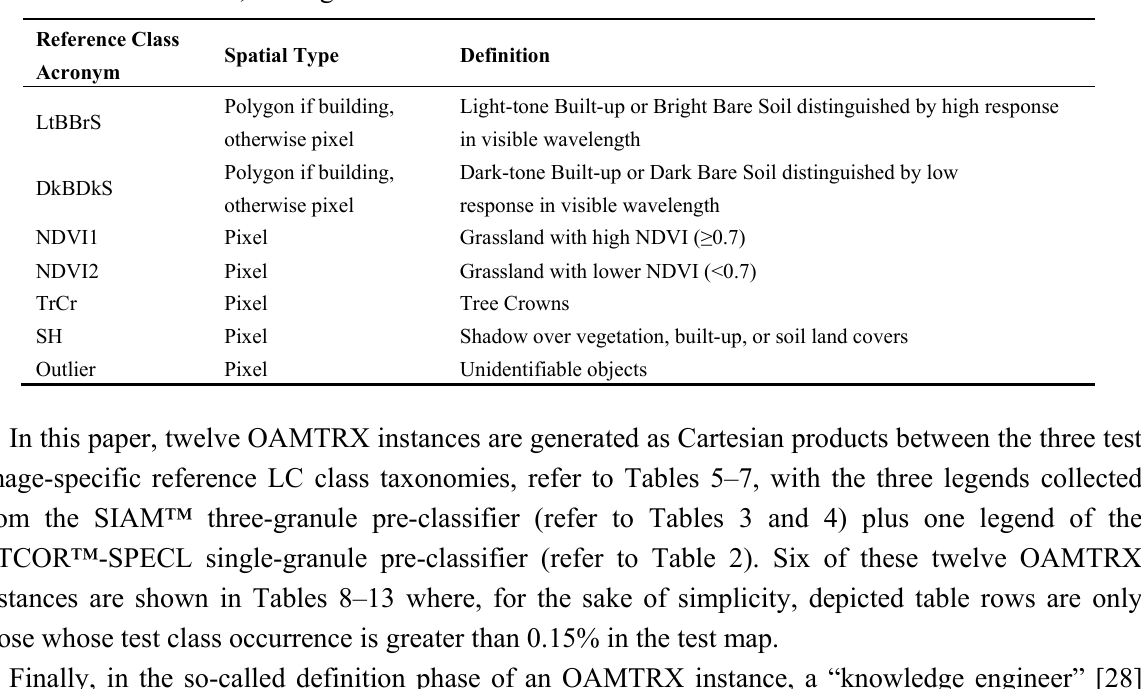
Table 7. Reference class definitions and acronyms for the Leica ADS-80 test image, 0.25 m resolution, see Figure